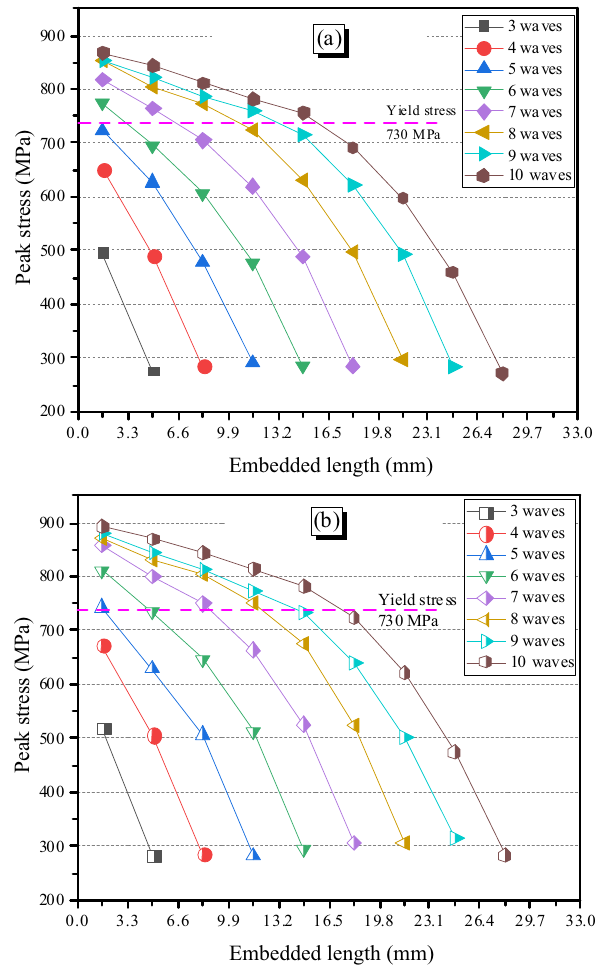
Figure 24: Pullout stress at the peak points with various numbers of embedded waves: ( a ) Wave_depth = 0.055 mm and ( b ) Wave_depth = 0.061 mm.